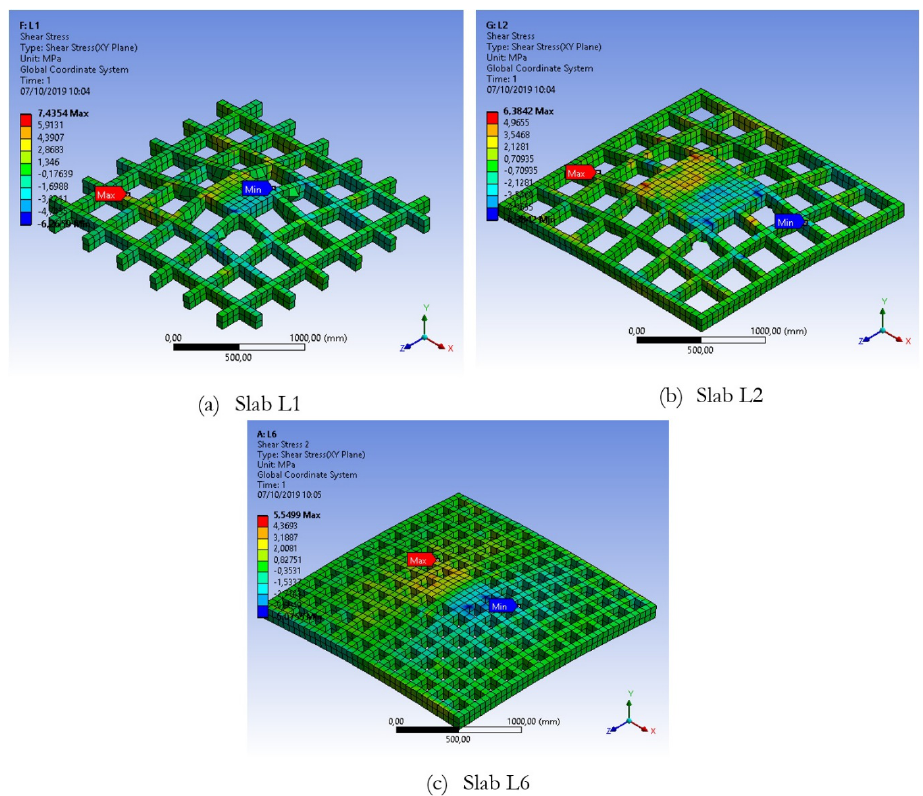
Figure 11. Shear stresses in the ribs of the slabs L1, L2 e